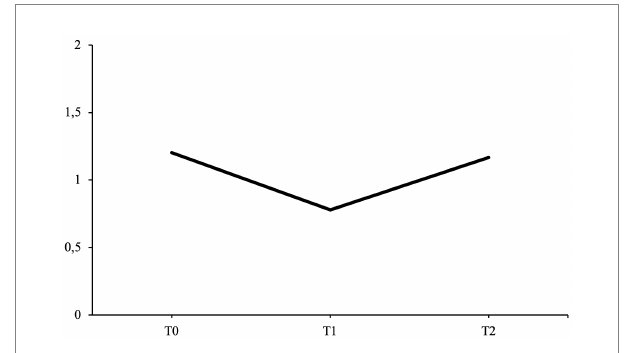
FIGURE 8 Average life story communion fulfillment scores at each interview